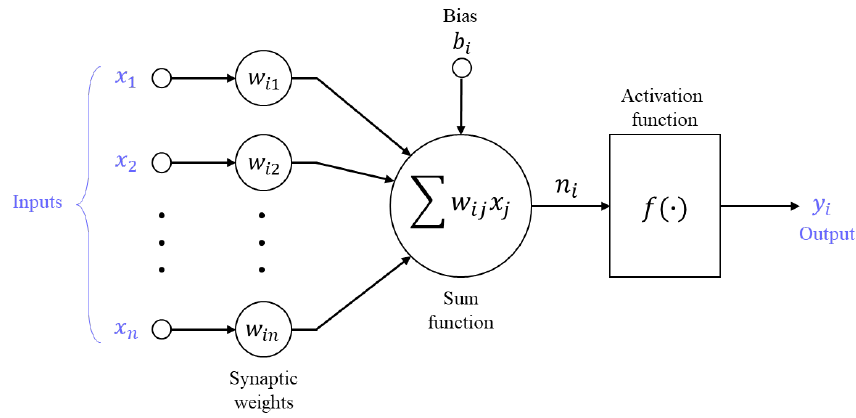
Figure 1. Artificial neuron model.